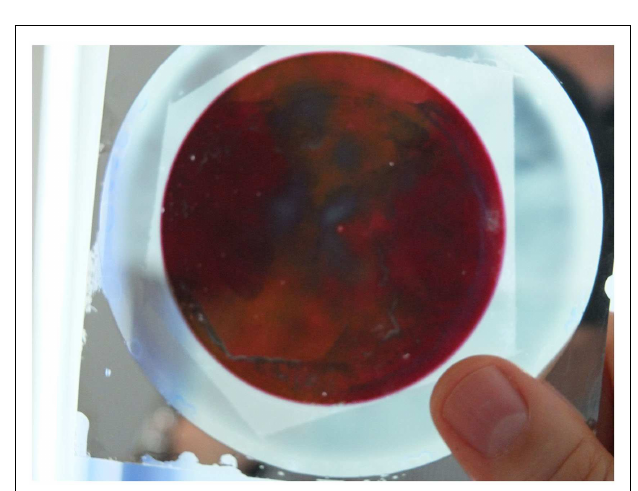
FIGURE 12 | (A) Photograph of electrodeposited Au-NRs on glass; the surrounding, non-anodized Al-film is still to be seen; inset shows the absorption spectrum of the Au-NRs. (B) shows a SEM micrograph of the